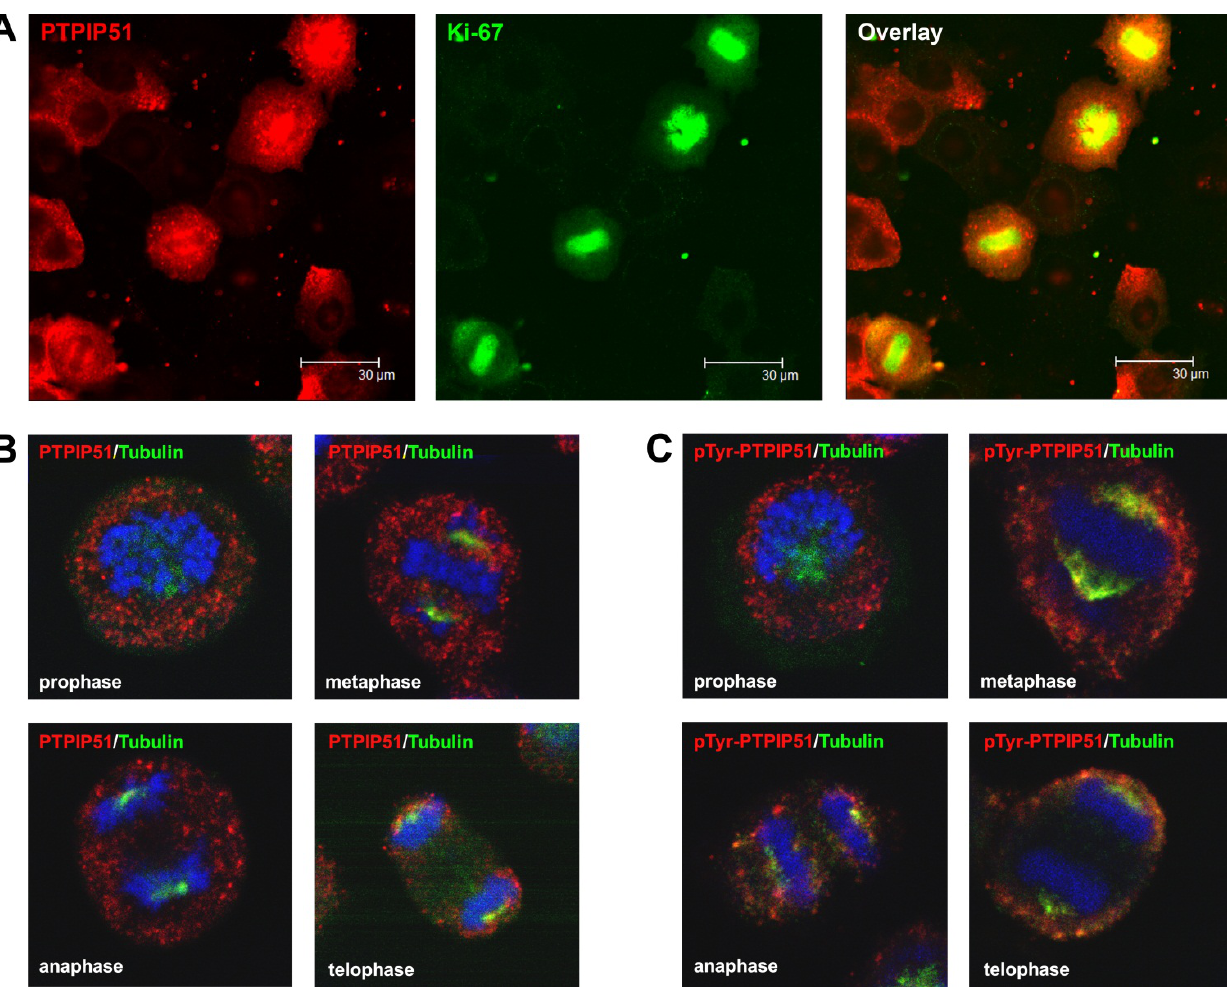
Figure 5. PTPIP51 protein expression during the cell cycle. ( A ) Confocal laser scanning microscopic picture of the PTPIP51 protein in proliferating HaCat cells. Cells were treated with nocodazole for cell cycle synchronization. Cells were analyzed in metaphase. PTPIP51 antibody: P51ab, Ki-67 antibody for identification of metaphase. ( B ) Confocal laser scanning microscopy of PTPIP51 and tubulin in the four mitotic stages. PTPIP51 antibody: P51ab. Nuclei marked in blue using To-Pro3. ( C ) Confocal laser scanning microscopic picture of the tyrosine 176 phosphorylated PTPIP51 protein and tubulin in the four mitotic stages. PTPIP51 antibody: P51ab-PTyr. Nuclei marked in blue using